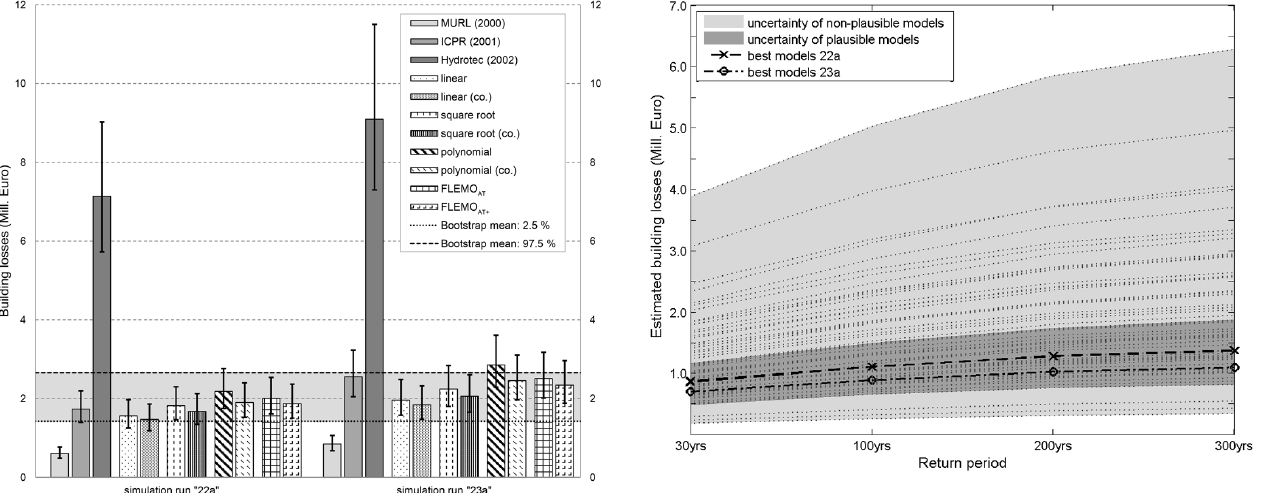
Fig. 5. Flood loss model estimations with error bars (due to the range of underlying asset values) for the flood event in August 2005 for the two hydraulic-simulation runs “22a” (dike heights as in 2005) and “23a” (dike heights as in 2005 but considering dike breaches) by means of the loss functions derived from the Bavar- ian subset. Loss estimates of the three standard functions (MURL, 2000; ICPR, 2001; Hydrotec, 2002) are also plotted here. The 95% confidence interval that was derived from reported losses by boot- strapping is highlighted in light grey.